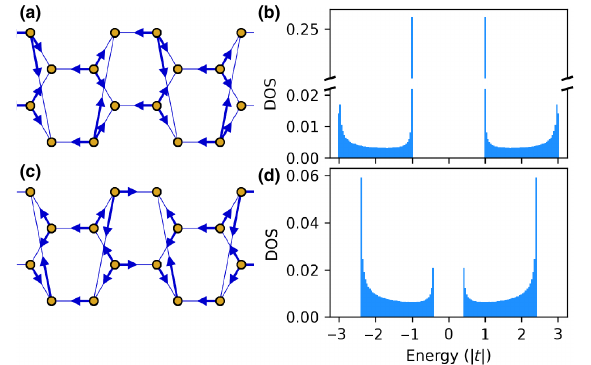
FIG. 8. n = 2, m = 0 nanotube. The unoriented version of this nanotube is one graph, which achieves the largest gap possible for any 3-regular graph [51,55]. The elementary orientation is shown in (a), with arrows on each edge indicating their orienta- tion. The elementary orientation necessarily has the same DOS (b) as the unoriented graph. Despite the presence of a peak in the DOS at − 3 and the absence of states in the interval ( − 1, 0], this orientation is not the ground state. (c),(d) The correspond- ing plots for a lower-energy orientation. This orientation has no eigenvalues near − 3 and there are states above − 1, but it does not have a flat band at − 1 containing a quarter of all the states. As a result, the total energy per particle at half-filling is approximately 0.033 lower than in the elementary orientation.